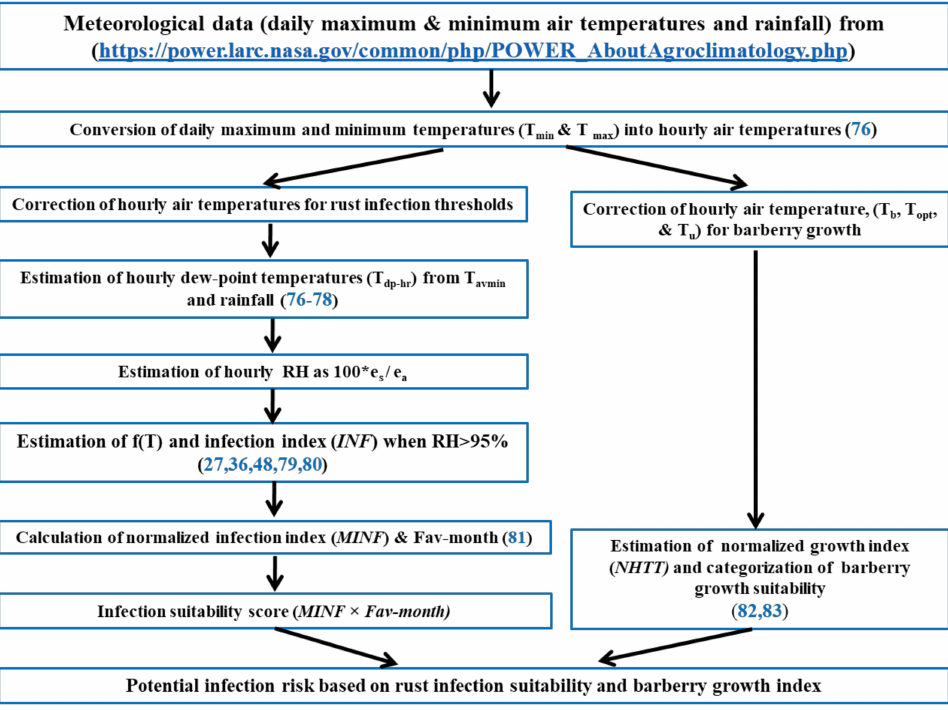
Figure 6. Modeling framework in the assessment of environmental suitability for basidiospore infection in barberry based on meteorological data (https://power.larc.nasa.gov/, accessed on 10 August